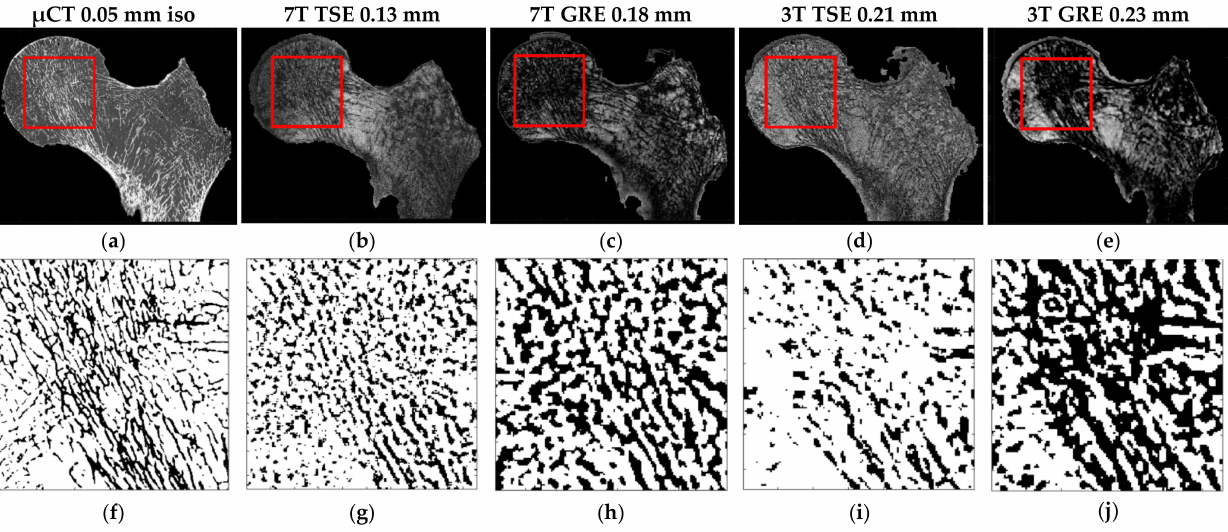
Figure 6. ( a – e ) S1 same coronal planes of the ( a ) µ CT and four different MRI acquisitions (( b ) 7T TSE, ( c ) 7T GRE, ( d ) 3T TSE and ( e ) 3T GRE). The red square identify the ROI extrapolated from all the registered images. ( f – j ) Corresponding ROI binarized (automatic local thresholding with a window size of 10 × 10